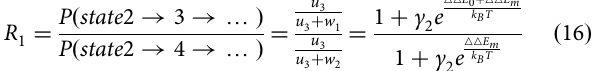
¼ 11 : 4. In the case of A3A, R with γ can be approximated as 1 2 44 E 0 e kBT . As A3A signi fi cantly prefers the TC motif to the GC motif (cid:6) 6 k ( 44 E T ) this ratio is larger than 400. As a result, for both 0 B A3A(WT) and A3A(N57G), the probability of having only the bystander edited is very low (Fig. 3b, blue line, almost zero). After the target cytidine is edited (Fig. 1, state 5), the system has the choice of getting released with the product CTT (Fig. 1, state 13)